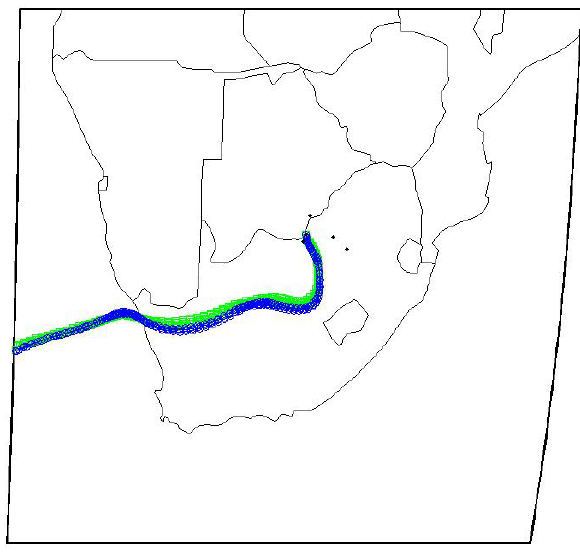
Fig. 5. 96h air mass back-trajectories during the first (green) and second (blue) nucleation and growth event of the day on 6 Novem- ber